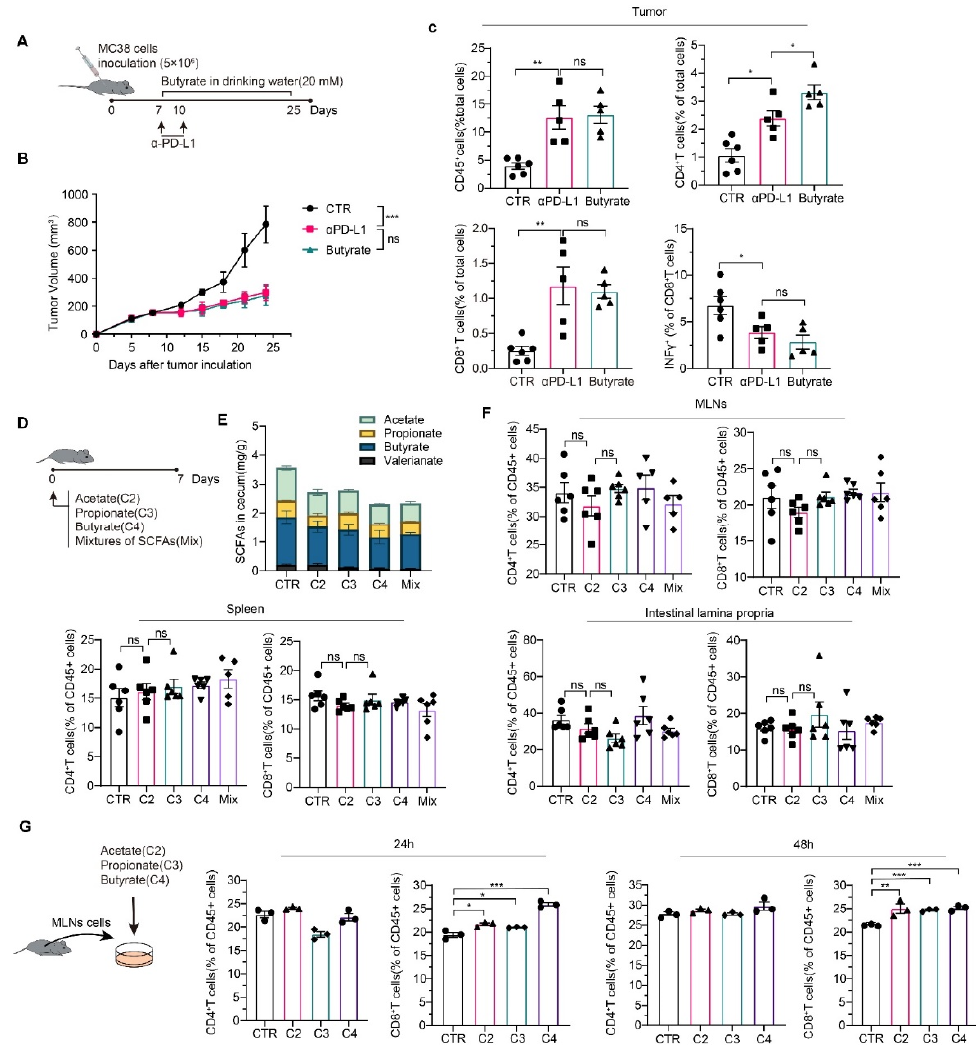
Figure 8. Effects of SCFAs on immune cell composition in vivo and in vitro. ( A ) Animal experiment design ( n = 6); ( B ) growth curve of tumor cells; ( C ) analysis of tumor-infiltrating lymphocytes by FACS; ( D ) animal experiment design: C57BL/6 mice were treated with 80 mM acetate (C2), propionate (C3), butyrate (C4), and mixtures of SCFAs (40 mM C2, 40 mM C3, and 40 mM C4) in drinking water for 1 week; ( E ) SCFA contents in cecum; ( F ) CD4 + T cells and CD8 + T cells in MLNs, spleen, and intestinal lamina propria were examined. ( G ) SCFAs directly affect CD4 + T cells and CD8 + T cells in MLNs in vitro. Data indicate the mean ± SEM; * p < 0.05, ** p < 0.01, *** p <